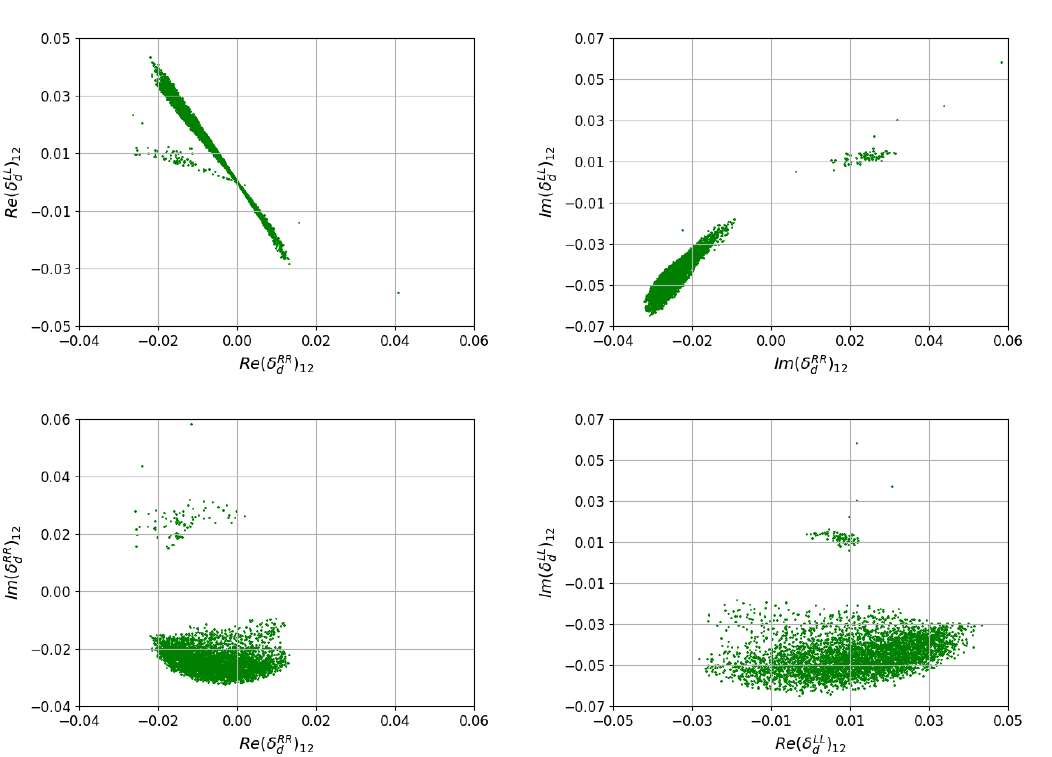
Figure 10 . Scatter plots of the real (upper left) and the imaginary (upper right) parts of the mass (cid:0) (cid:1) (cid:0) (cid:1) insertions (cid:14) RR and (cid:14) LL for B ( K 0 ! (cid:22) + (cid:22) (cid:0) ) > 2 (cid:2) 10 (cid:0) 10 , of the real vs. imaginary S d d 12 12 (cid:0) (cid:1) (lower left) and of the real vs. imaginary (cid:14) LL (lower right). All points in the plane pass the d 12 experimental constraints de(cid:12)ned in section 2. The up-type MI ( (cid:14) LL ) 12 is given by eq. (2.2). The u plots correspond to Scenario C, with a sample of 4378 points with B ( K 0 ! (cid:22) + (cid:22) (cid:0) ) > 2 (cid:2) 10 (cid:0) 10 and S (cid:31) 2 < 12 : 5, produced after 6M generations of 200 k points each. The pattern observed in Scenario A is very similar.